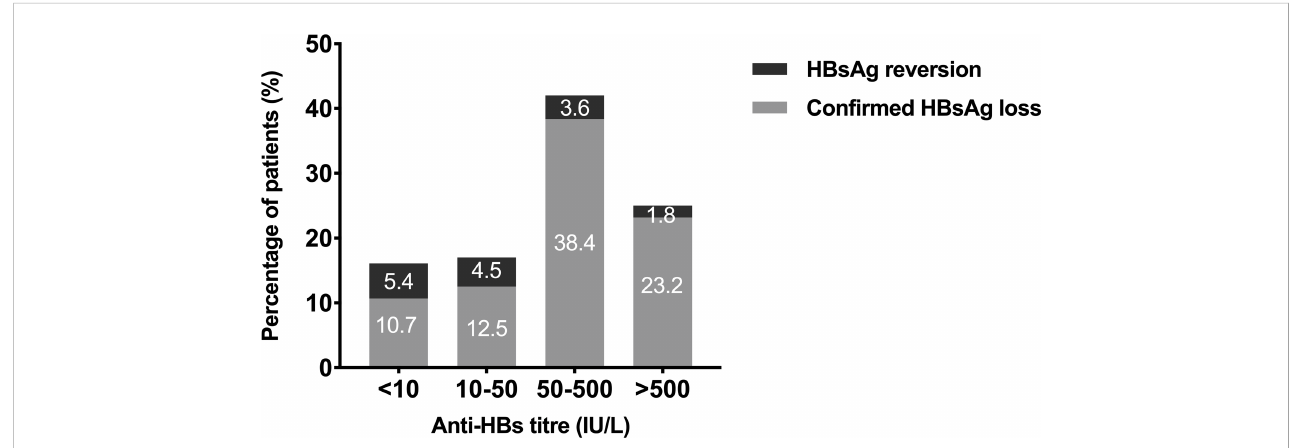
FIGURE 5 Percentage of patients with HRV according to different anti-HBs levels at EOT. HRV, HBsAg reversion; Anti-HBs, hepatitis B surface antibody; EOT, end of PEG-IFN